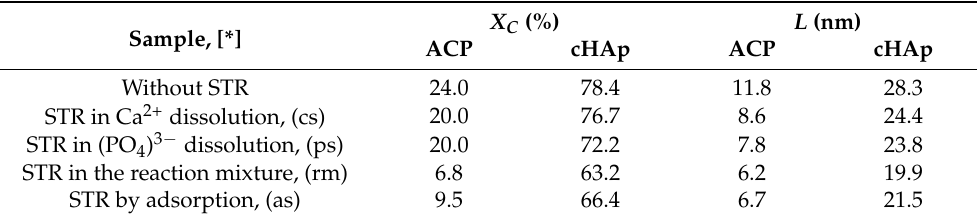
Figure 5. X-ray diffractograms of unloaded and STR-loaded nanoparticles and STR as a control ( a ). Indexed Bragg peaks for the cHAp as sample ( b ). Table 2. Degree of crystallinity ( X C ) and crystallite size ( L ) of the unloaded and STR-loaded samples. [*] indicates the loading path of the drug in the